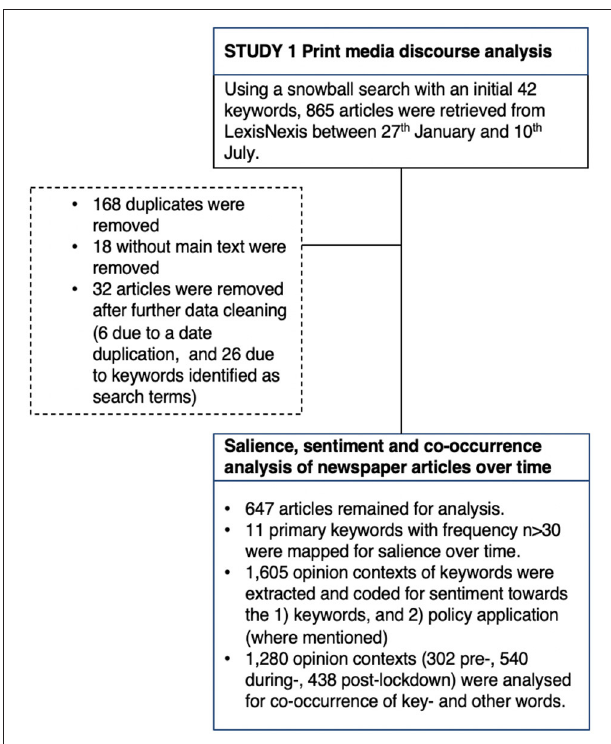
FIGURE 1 | Flowchart of data selection and cleaning process for Study